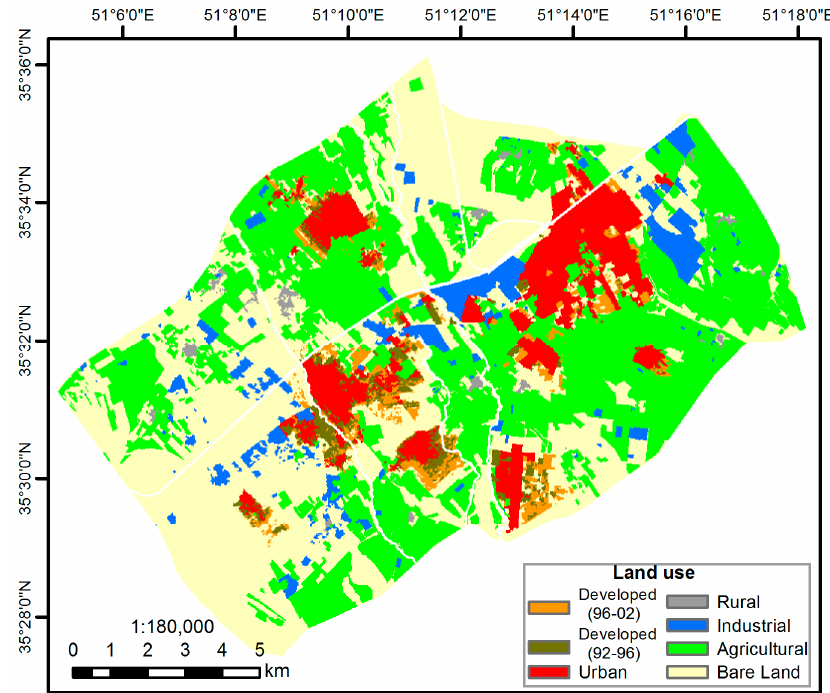
Figure 3. Land use map of the study area in 1992 and urban areas that developed during the